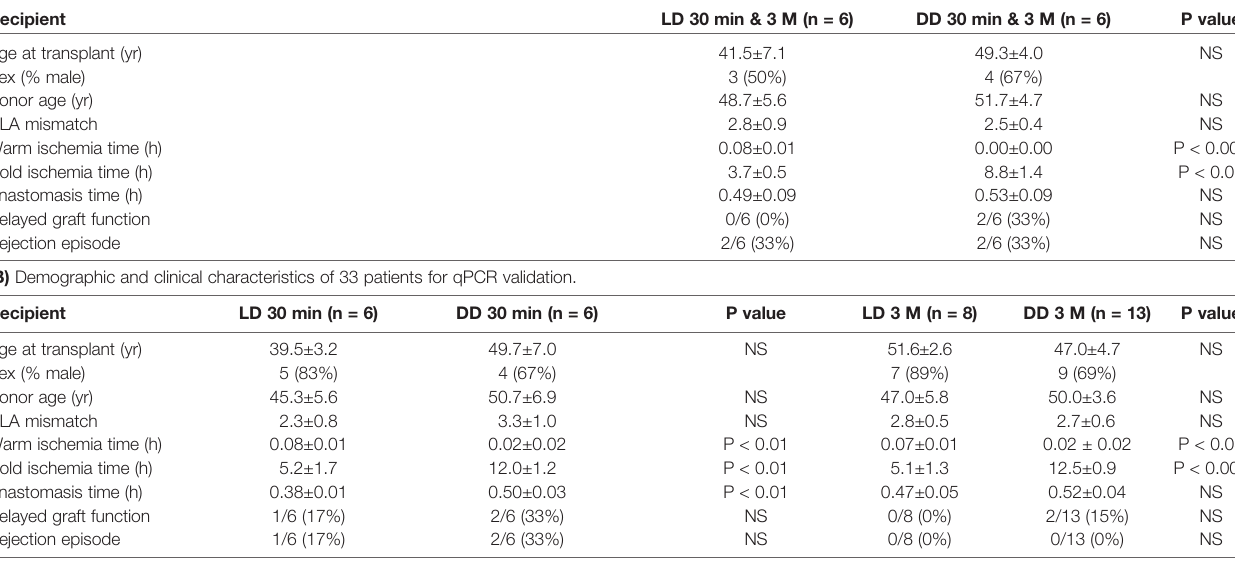
(A) Demographic and clinical characteristics of 12 patients for microarray analysis. Recipient Age at transplant (yr)